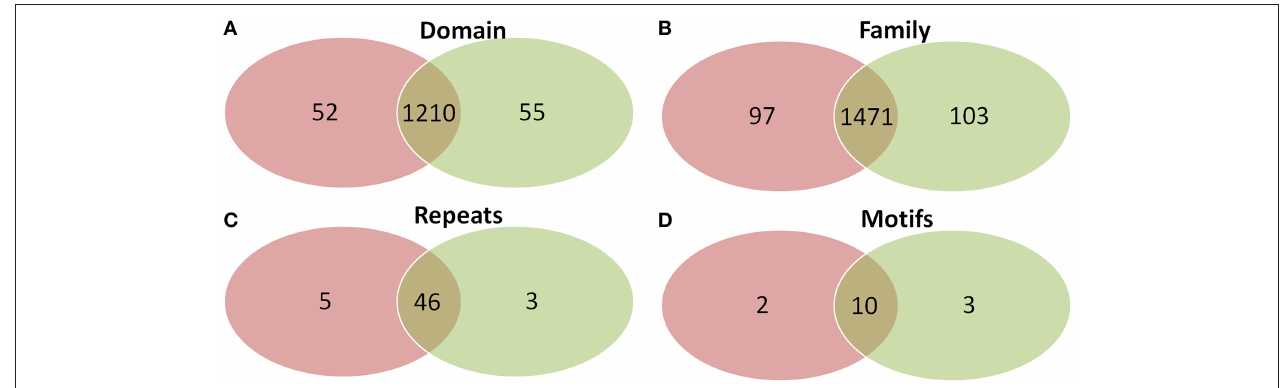
FIGURE 6 | The Venn diagram of the domains (A), families (B), repeats (C), and motifs (D) present in the in the old “prokaryotic” proteins in Arabidopsis (green) and Oryza sativa (pink). The diagram shows similarity which old “prokaryotic” proteins share with respect to domains, families, repeats, and motifs in the two